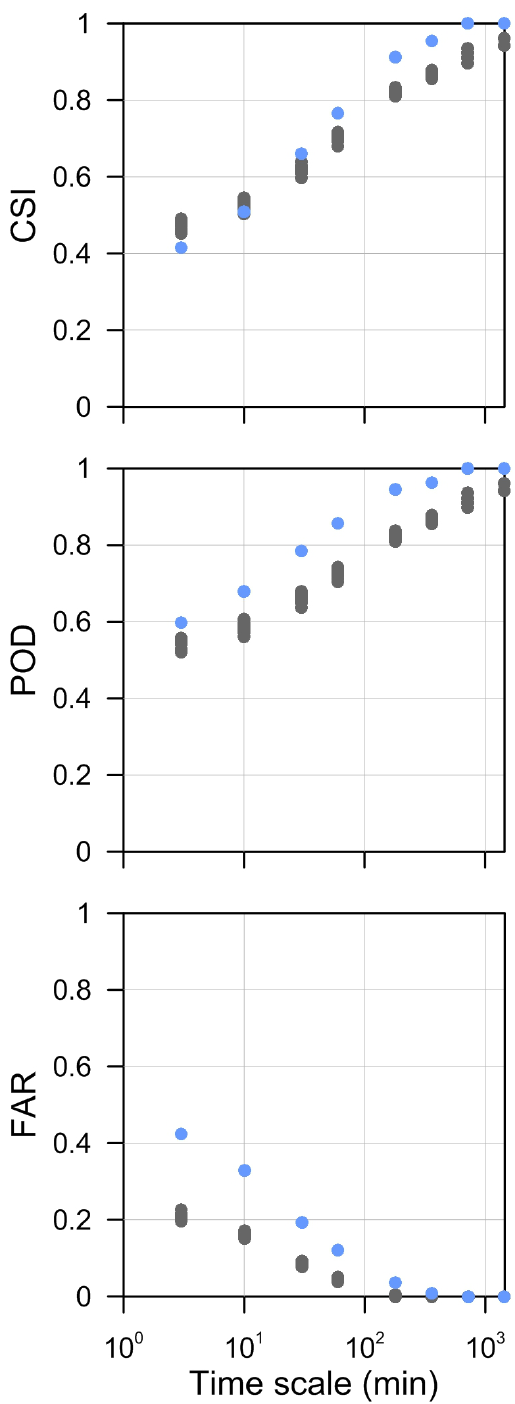
Fig. 8. Critical success index (CSI), probability of detection (POD) and false alarm ratio (FAR) for the different timescales. Gray dots represent the radar pixels and blue dots represent the averaged radar